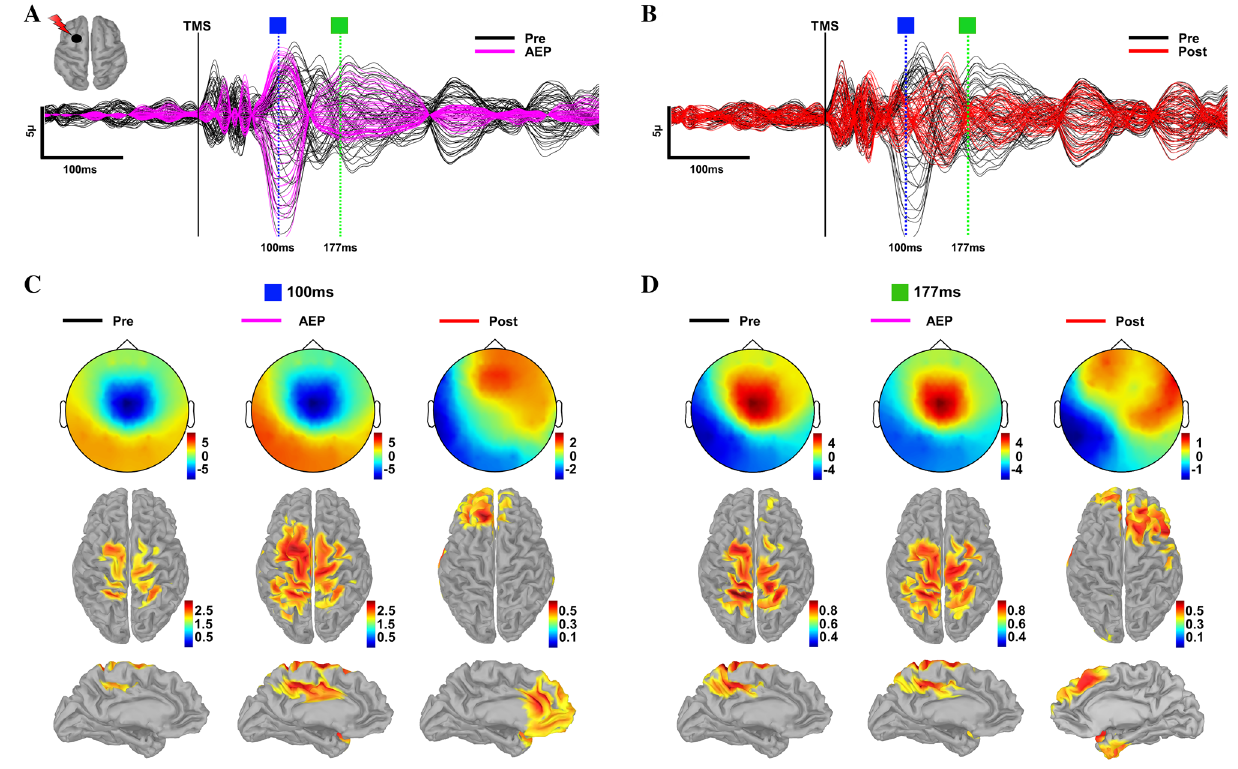
Figure 4. Source reconstruction of TEPs pre- and post-AEP removal. ( A ) TEPs from DLPFC pre- (black) AEP removal and AEP component (magenta) time series for a representative subject with selected peaks. ( B ) TEPs in ( A ) pre- (black) and post-(red) AEP removal for this same subject with selected peaks. ( C ) Topography and corresponding source reconstructions at 100 ms for pre- (left), AEP (middle) and post- (right) AEP removal. ( D ) Topography and corresponding source reconstructions at 177 ms for pre- (left), AEP (middle) and post- (right) AEP